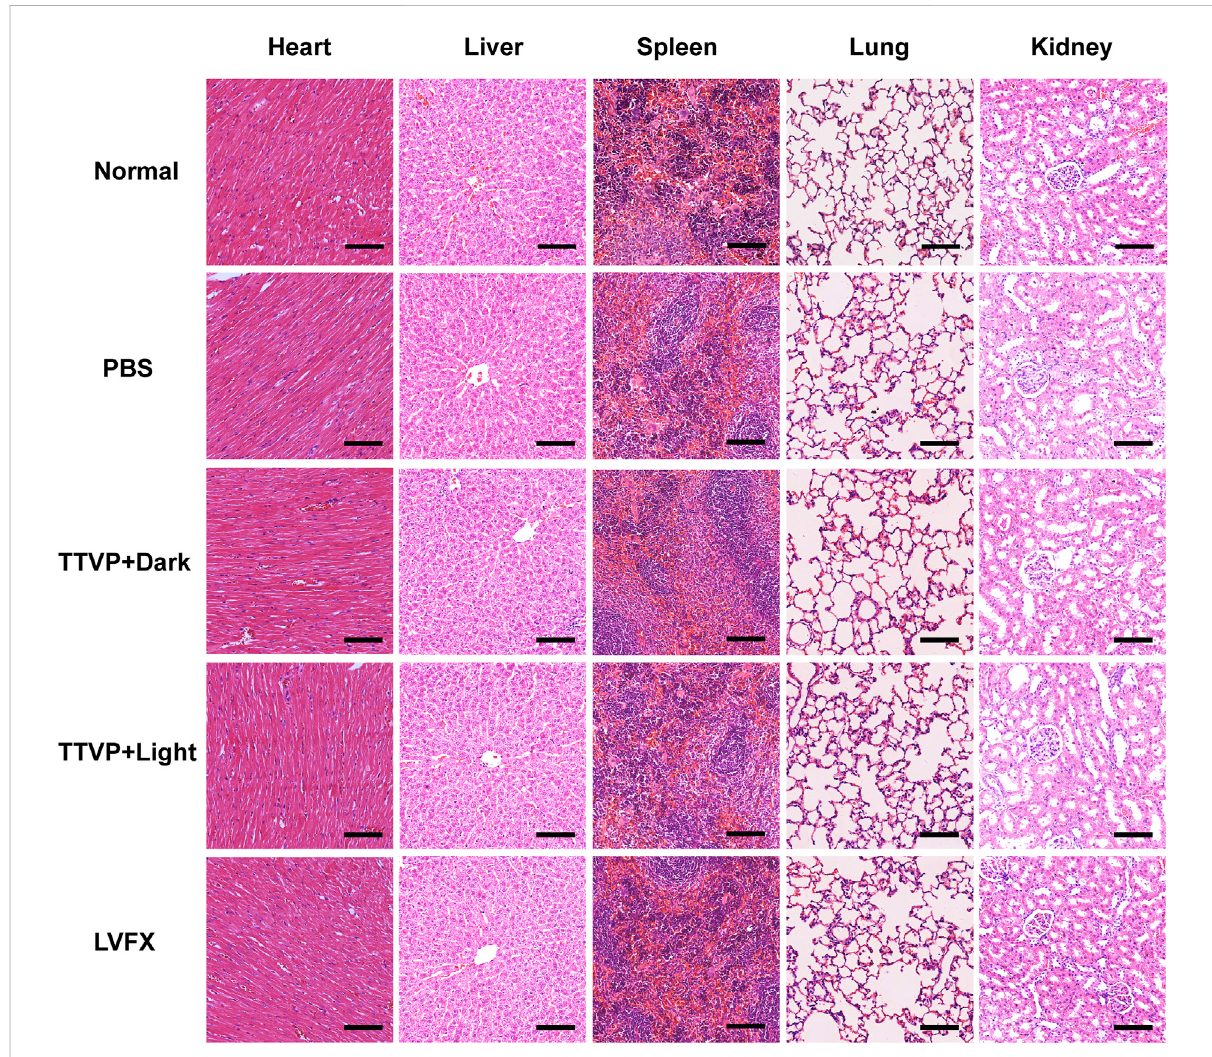
FIGURE 6 H & E staining of main visceral organs at 7 days post treatment (heart, liver, spleen, lung and kidney, scale bar: 100 μ